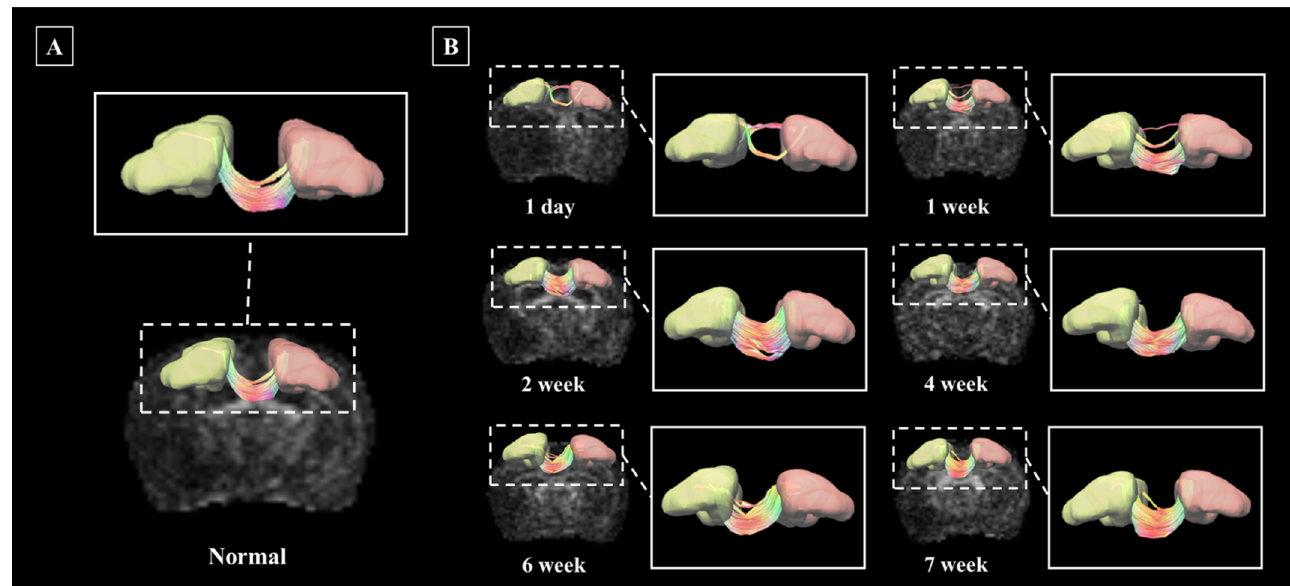
Figure 6. Nerve pathways in the Left M1 and Right M1 regions, shown in D rendering. Linkage pathways of normal rats ( A ), and linkage pathways by date of disease occurrence in a stroke rat model ( B ). Rendered structures and connection paths are represented as axial planes, and connection paths between structural regions are enlarged and presented in greater detail.Abbreviations: Primary motor cortex, M1.